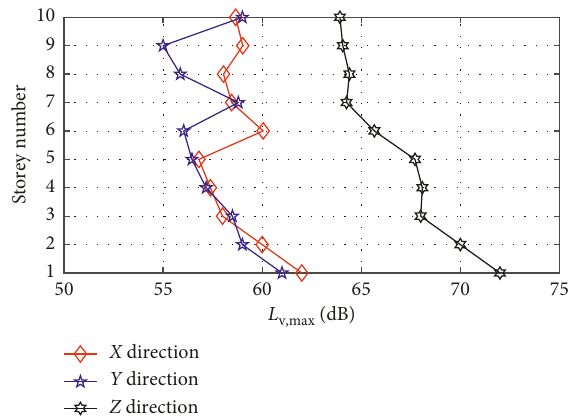
Figure 20: The distribution of velocity level along the high-wise (damping ratio